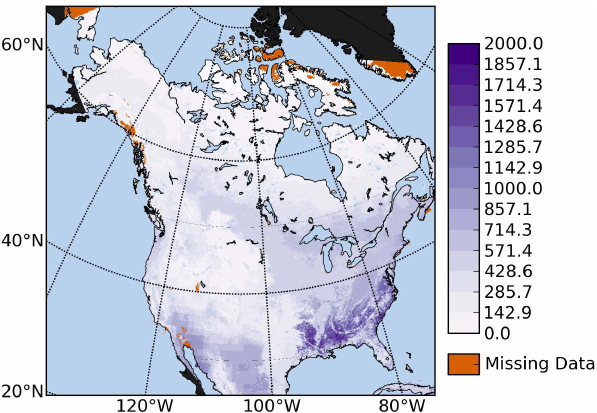
Fig. 8. The 2002 annual integrated VPRM respiration, gCm − 2 yr − 1 . PFT–all-data VPRM parameters. Black areas are outside of the study domain.